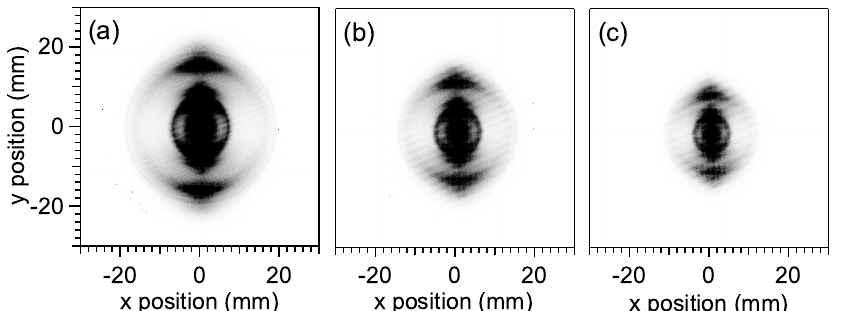
Figure 5. The raw images of O + ions by dissociative ionization of O 2 with a 800 nm femtosecond laser with an intensity of 1.5 × 10 14 W/cm 2 at different sets of the electron arm: ( a ) 100 eV, ( b ) 300 eV, ( c ) 600 eV, respectively.